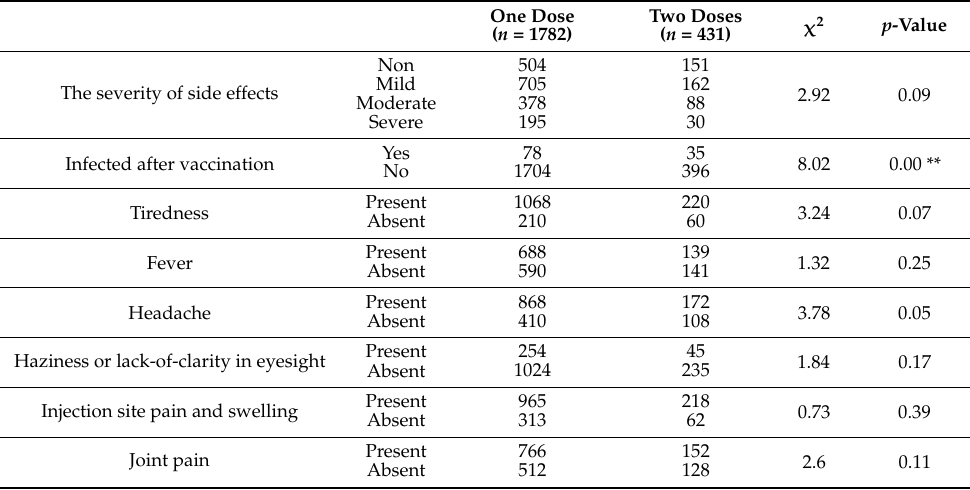
Table 5. Association of each post-vaccination side effect with the number of